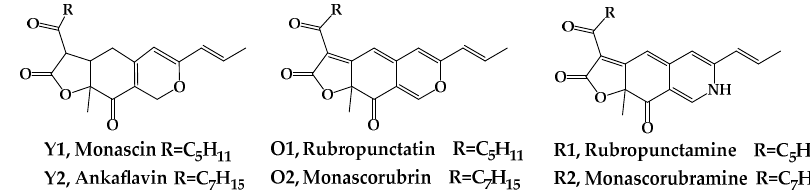
Figure 1. The major six molecular structures of MonAzPs.